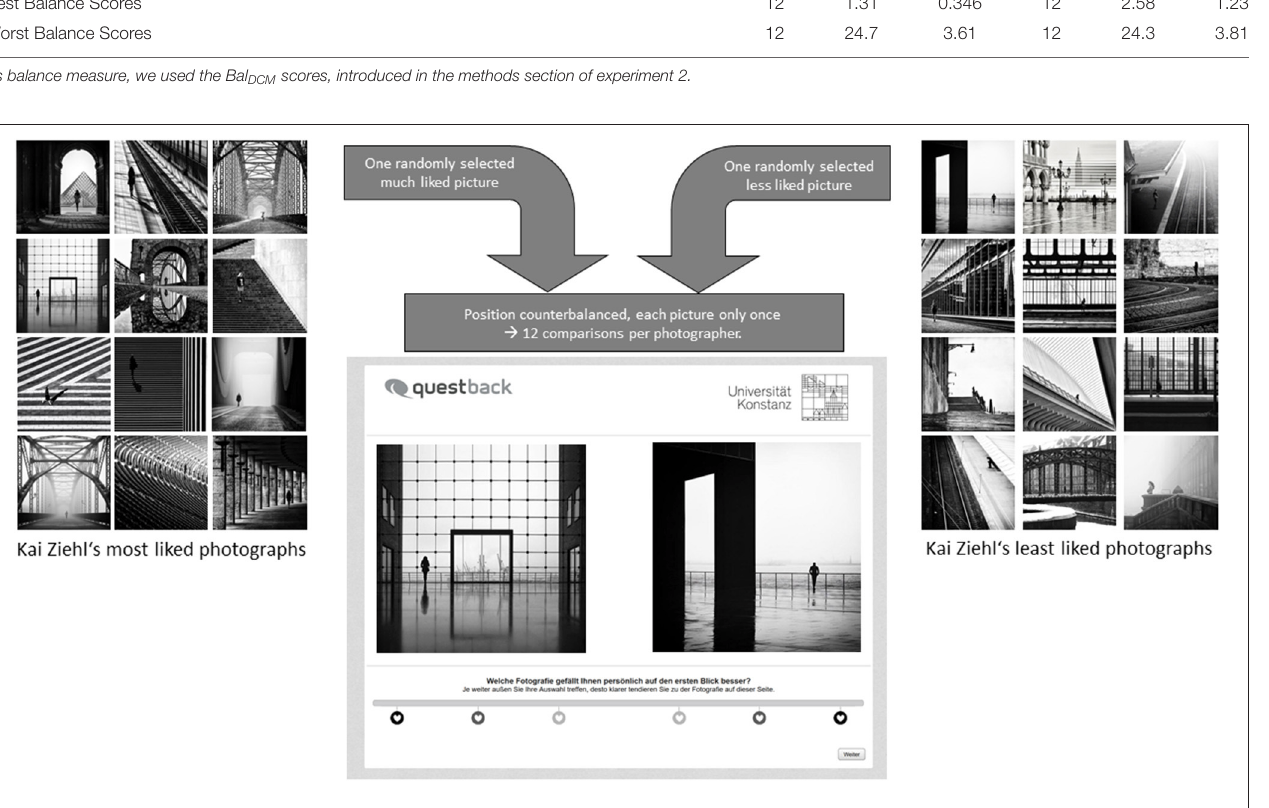
Frontiers in Psychology |